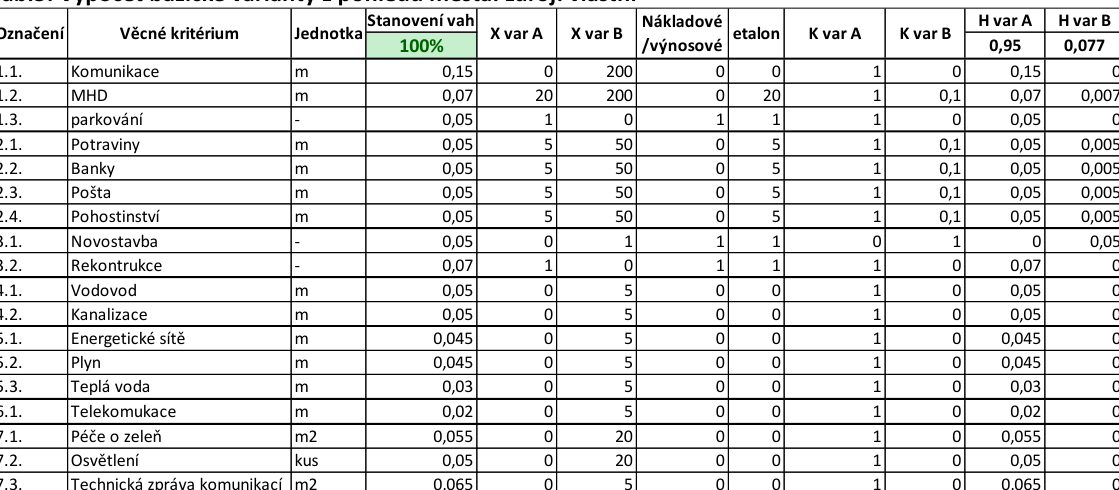
Tab.3: Výpočet bazické varianty z pohledu města. zdroj: